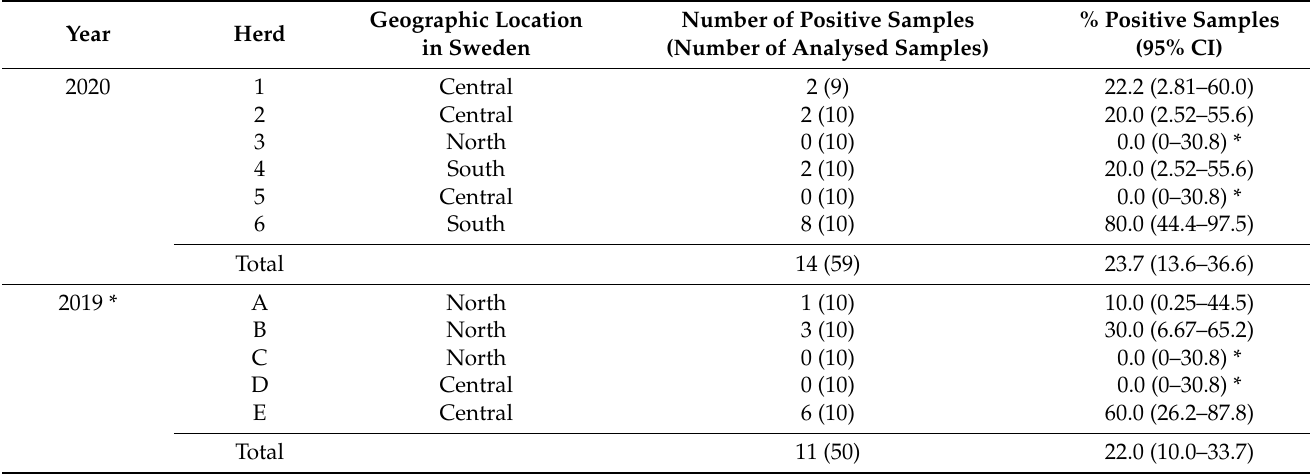
Table 2. Number of positive goats from herds in South, Central and North Sweden sampled in August–September 2020 and in 2019, including geographical location and their seropositivity